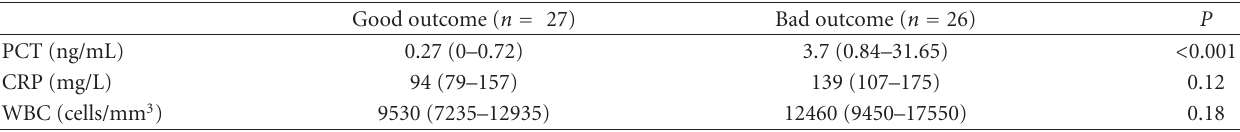
Table 2: Biological parameters at 48 h after CA.